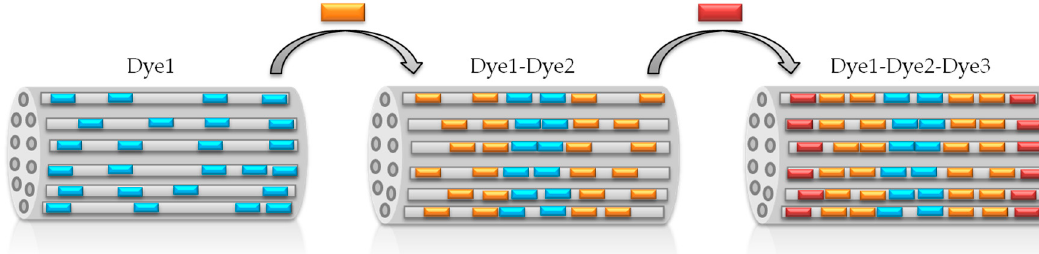
Figure 3. Sketch of the sequential insertion of the fluorophores into the LTL zeolite channels.